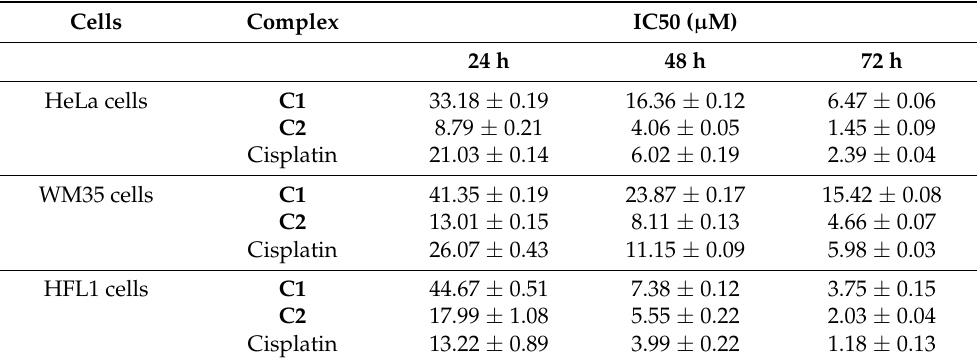
Table 2. IC 50 values of the complexes C1 and C2 and cisplatin on the human cervical carcinoma line (HeLa), human radical growth phase melanoma cell line (WM35), and normal fibroblastic